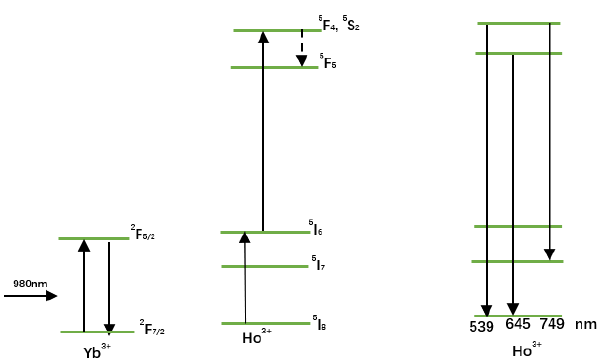
Figure 6. Fluorescence peak of different substrates. Adapted with permission from Nie J et al. [86].